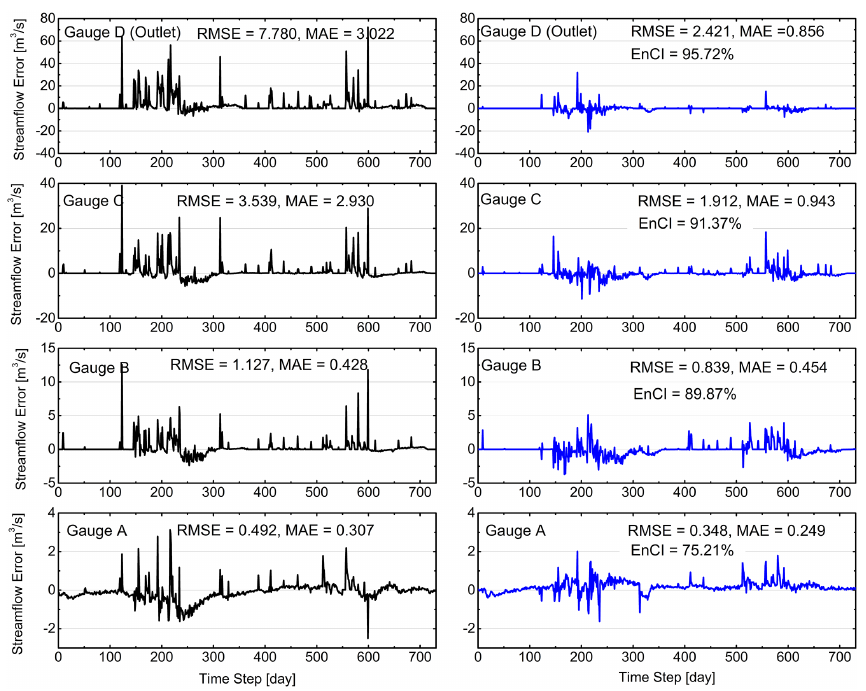
Figure 2. Streamflow prediction errors from the control-run simulation (left column) and the data assimilation of scenario ASS_D (right column), i.e. only the observed streamflow from Gauge D (outlet) is assimilated to update model states and